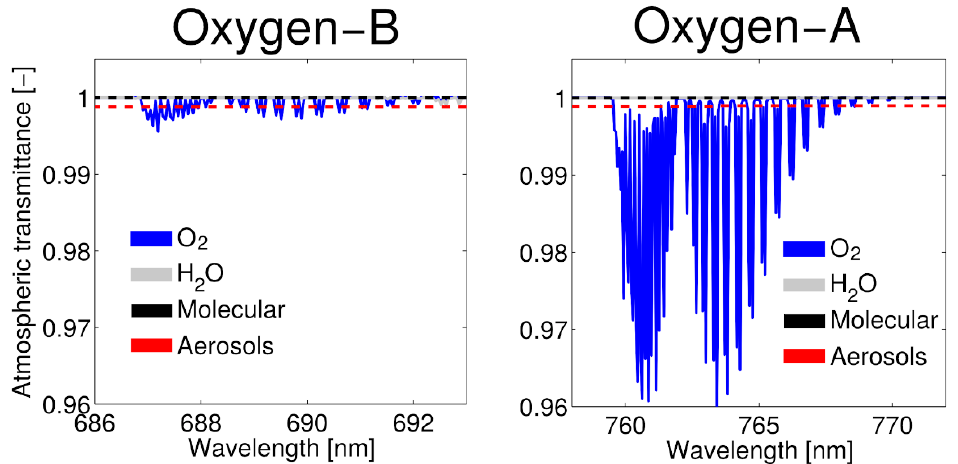
Figure 8. Simulated upward atmospheric transmittance components for a 10 m sensor height. Simulations were performed with the MODTRAN5.02 RTM using the mid-latitude summer atmospheric model and the default rural aerosol model with 23 km of visibility and at a spectral resolution of 1 cm − 1 , i.e., around 0.05 nm at the O 2 -B and 0.06 nm at the O 2 -A (figure modified from Sabater et al. [117]).